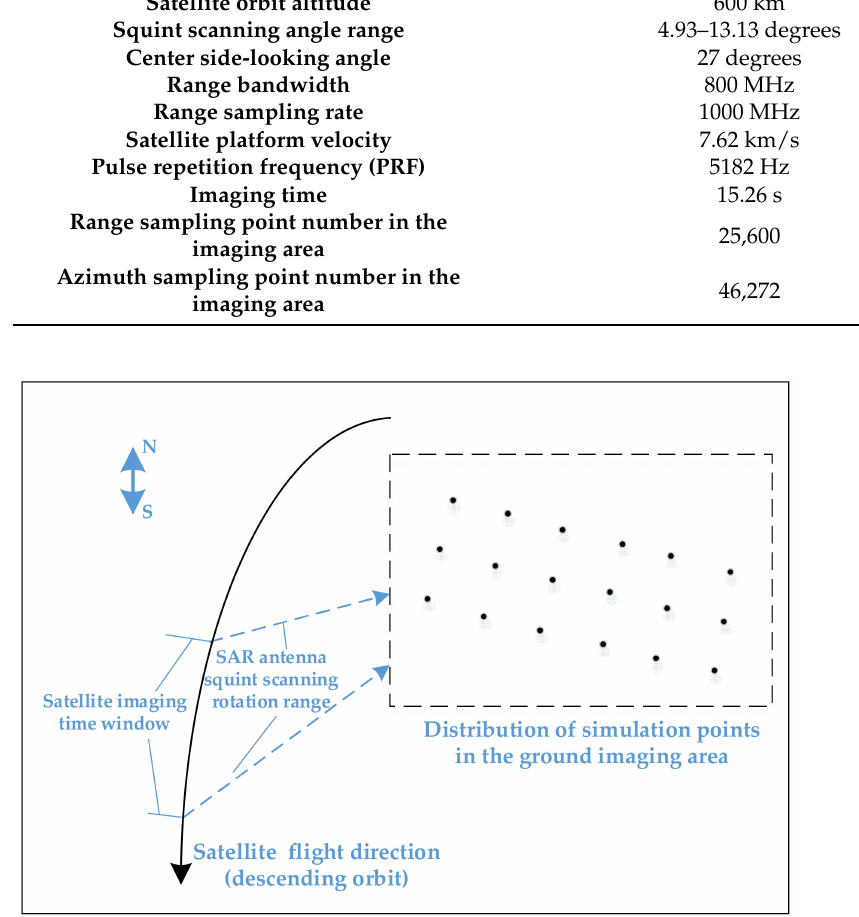
Figure 1. The satellite-to-ground position relationship in the simulation and the distribution of simulation